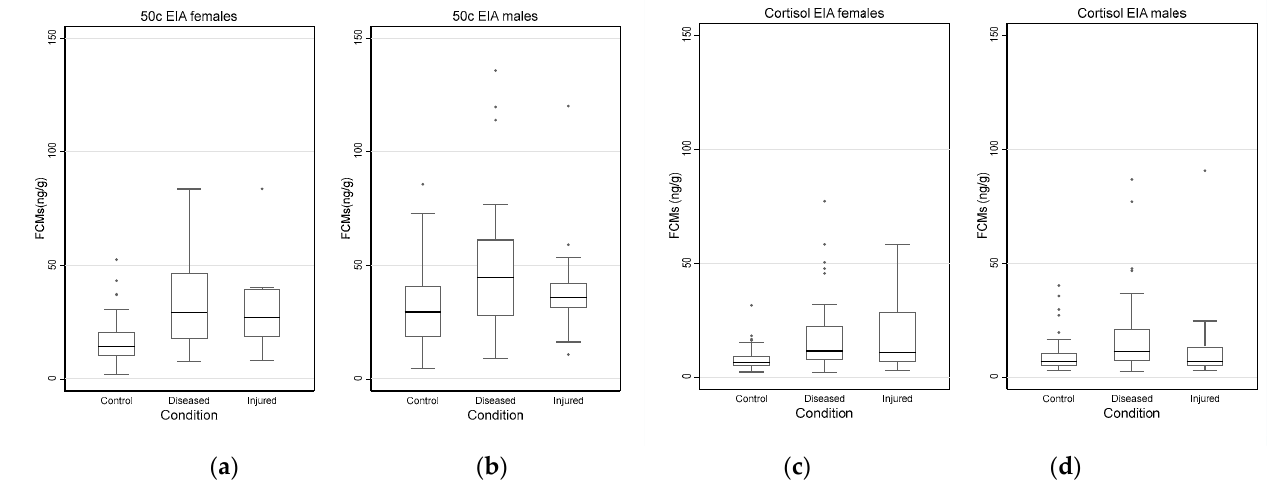
Figure 7. Box and whisker plots showing FCM (faecal cortisol metabolite) values (ng/g) for females and males in control (females N = 63; males N = 61), diseased (females N = 42; males N = 34) and injured (females N = 11; males N = 19) koalas, as measured with the 50c ( a , b ) and cortisol ( c , d ) EIAs (enzyme immunoassays) on the first collection day.